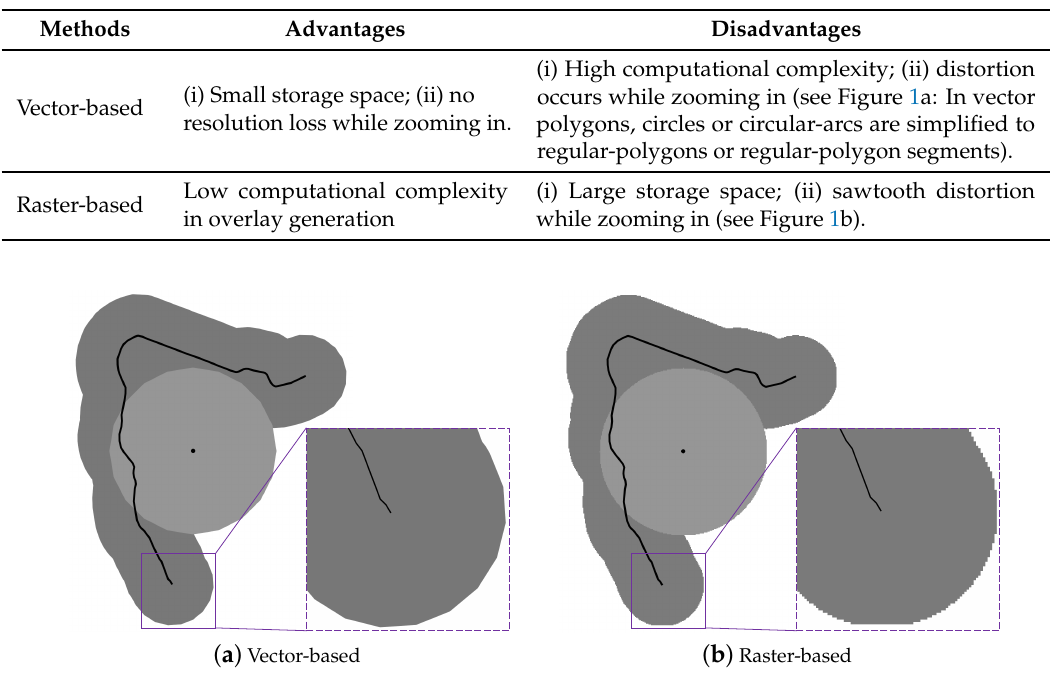
Figure 1. Distortion of vector-based and raster-based results while zooming in. Table 2. Performance of traditional buffer generation